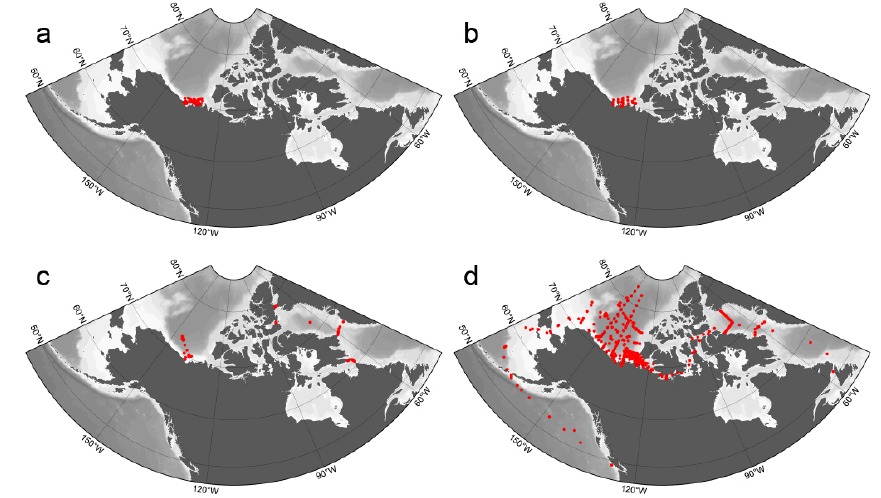
Figure 2. Map of all stations in the data set by decade: (a) 1970–1979, (b) 1980–1989, (c) 1990–1999, and (d) 2000–2009. Table 2. List of the cruises included in the time-series data set and the associated information regarding their CO 2 data. A question mark indicates information that is